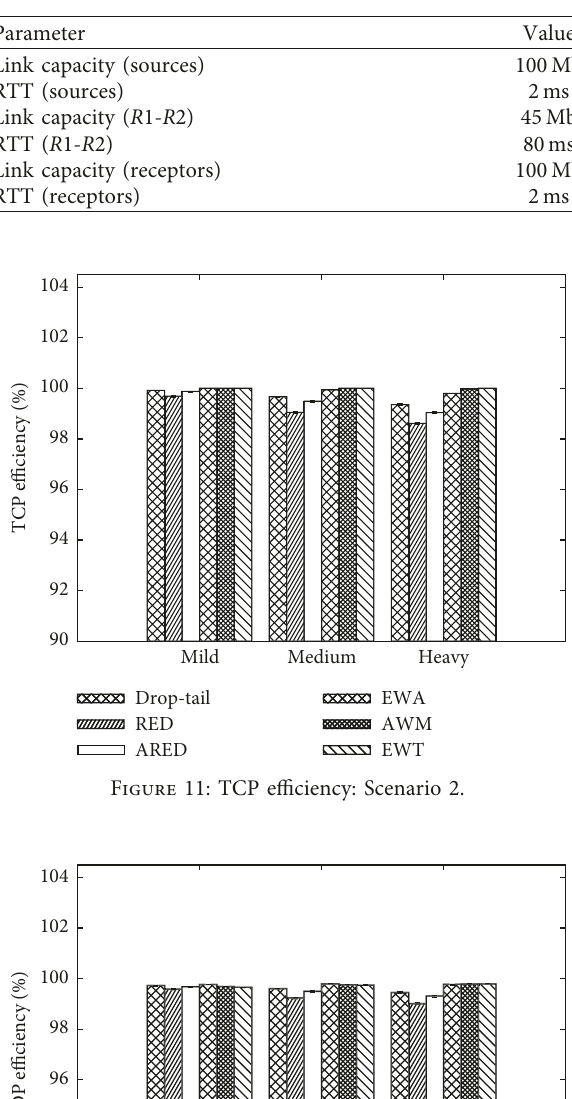
Table 5: Parameters of Scenario 2.